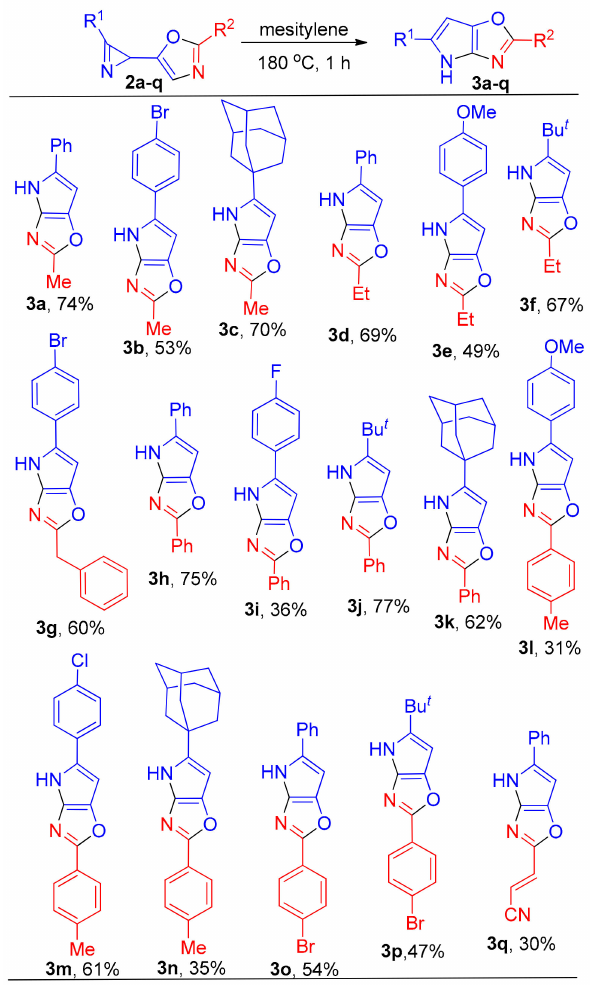
Figure 2. Synthesis of 4 H -pyrrolo[2,3- d ]oxazoles 3 . The reaction tolerates a variety of substituted aryl and alkyl groups at the 3 position (R 1 ) in azirine fragment and at the 2 position (R 2 ) in oxazole fragment of starting com- pounds 2 and affords the desired products 3 in generally good yields (30–77%). Whereas heating compounds 2r and 2s with vinyl and chloromethyl substituents resulted in com- plete resinification of the reaction mixtures. All new compounds were characterized by 1 H, 13 C-NMR and HRMS methods. Moreover, the structure of 3d was also confirmed by single- crystal X-ray diffraction analysis (Figure 3). Pyrrolooxazoles 3a-q are non-hygroscopic crystalline solids, which are stable under an air atmosphere for at least 3 months at